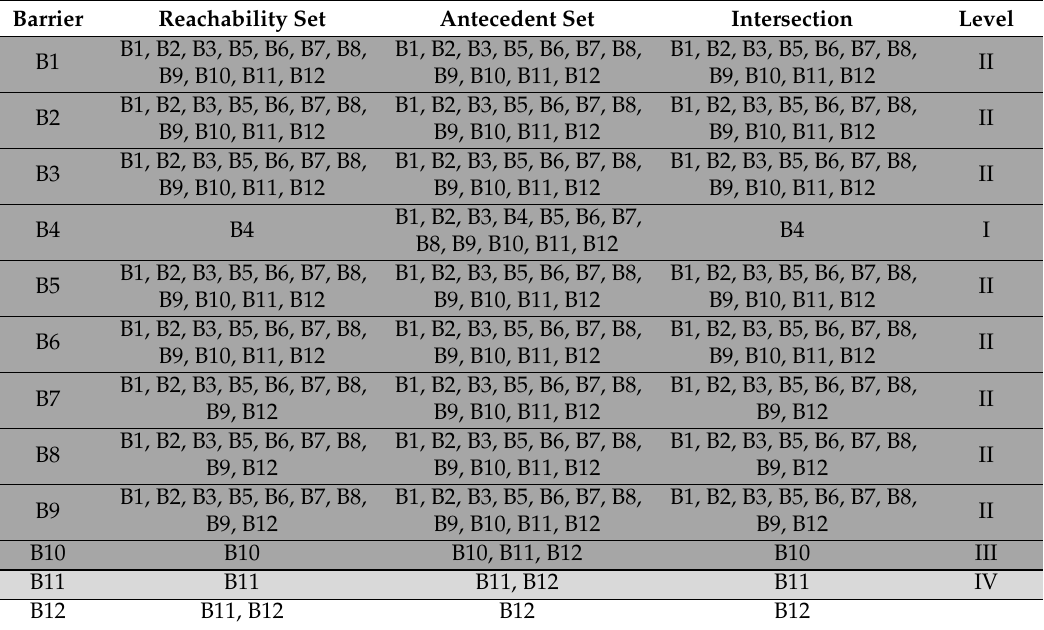
Table 8. Partition matrix (PM) and barrier (B1–B12) levels—4th iteration of ISM computations. Barrier Reachability Set Antecedent Set Intersection